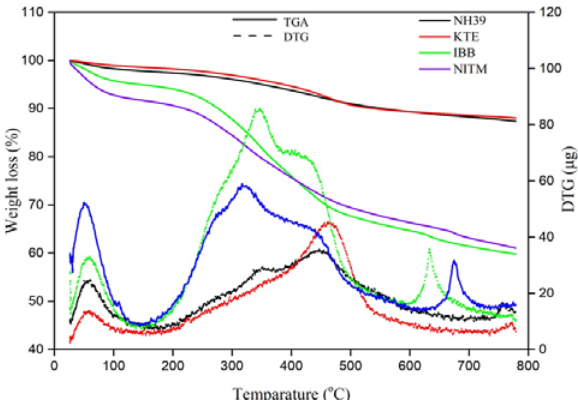
Figure 9. Thermal analysis of Northeast Indian